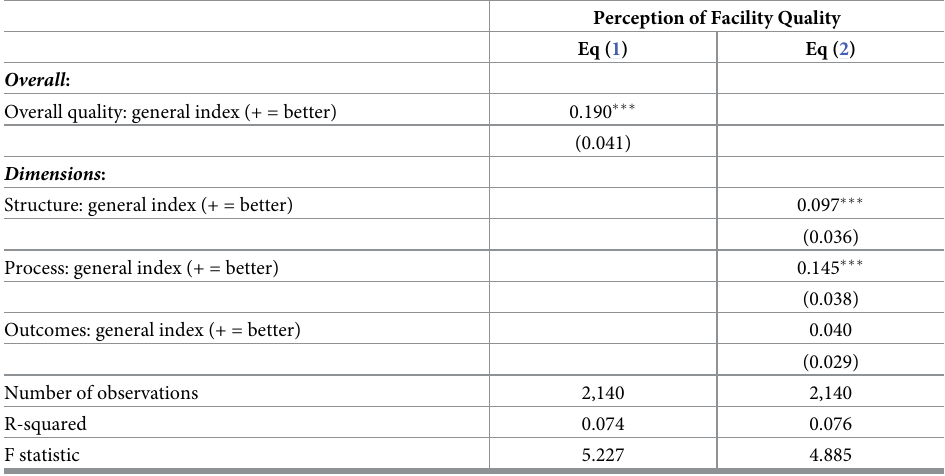
Table 6. Quality of care and the perception of